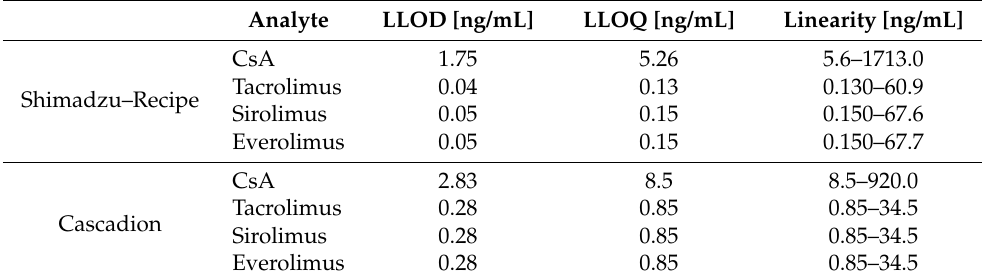
Table 3. LLOD (Lower Limit of Detection), LLOQ (Lower Limit of Quantitation), and linearity are shown both for Shimadzu–Recipe and for Cascadion, together with the corresponding times for calibration and analysis of 50 samples per day for a total of 30 days.